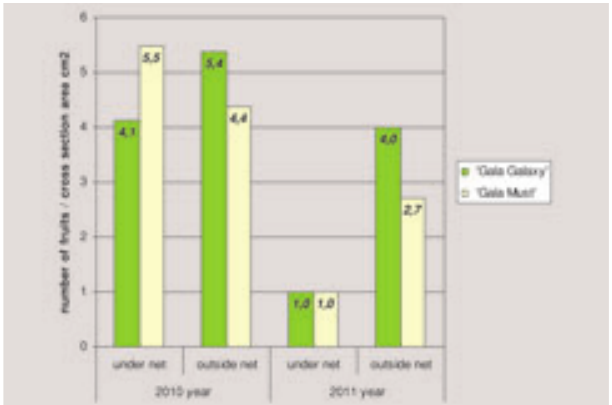
Figure 3. Specific number of fruits of apple varieties under and outside the hail nets in the successive years (Debrecen-Pallag,